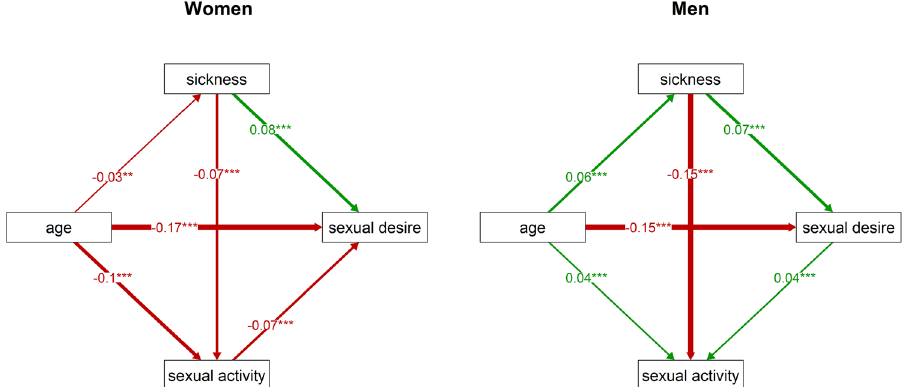
Figure 3. Direct and indirect effects of the sickness index on sexual desire in women and men. This figure charts the results of path analyses: it shows relations between sexual desire, the sickness index, sexual activity, and age, separately for women (left) and men (right). The numbers at arrows show standardised parameter estimates. It is more parsimonious to expect that in men, sexual desire positively influences sexual activity than that sexual activity positively influences sexual desire. The direction of the arrow between sexual desire and sexual activity was therefore reversed in the men’s model (see “Discussion”). Associations with p values under 0.01 are marked by ‘**’, and those with p values under 0.001 are marked by